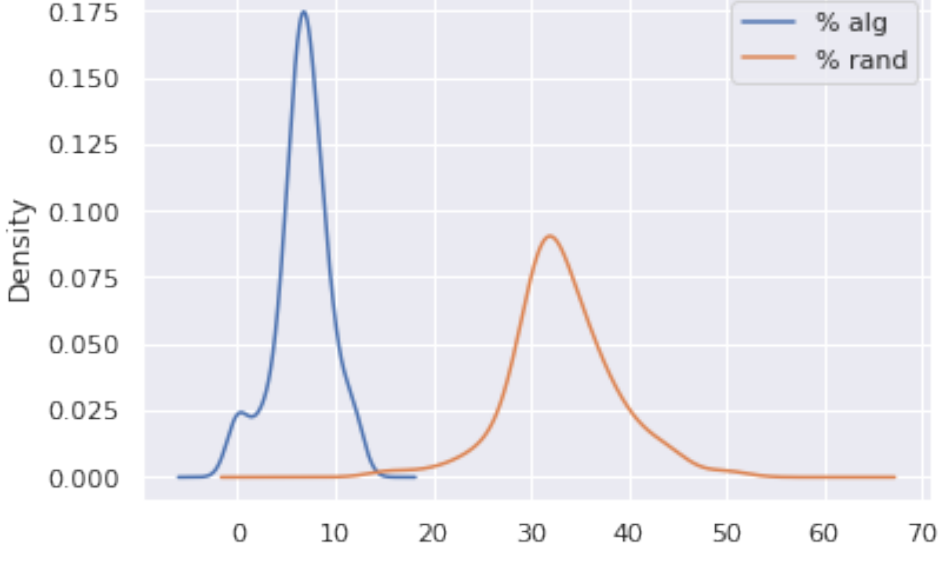
Figure 8. Percent error. Table 1. Basic statistics for percent